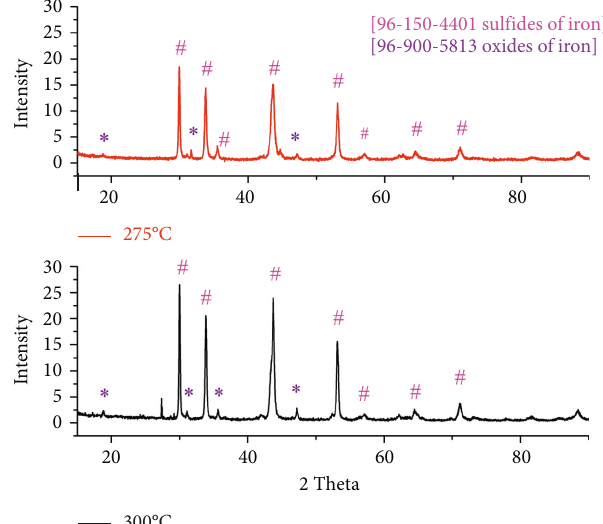
Figure 6: XRD spectra of hard deposit samples.